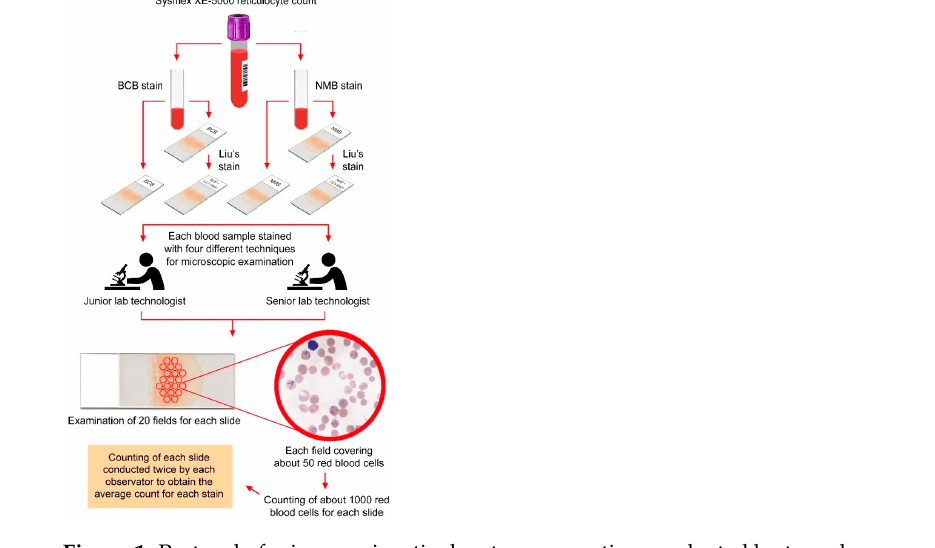
Figure 1. Protocol of microscopic reticulocyte enumeration conducted by two observers using blood smear stained with four different methods. BCB—brilliant cresyl blue; BCB + LIU—BCB with